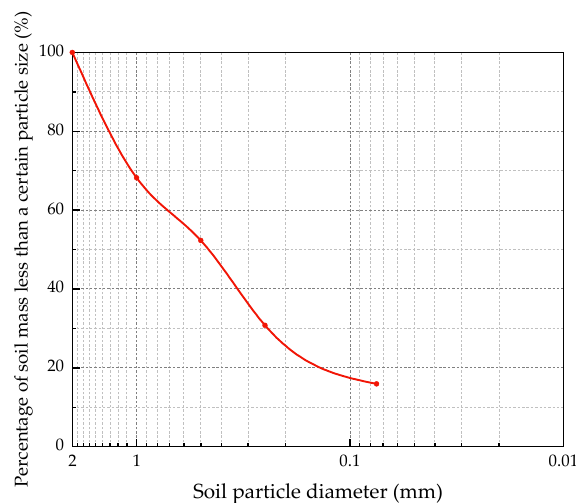
Figure 1. Particle gradation diagram.